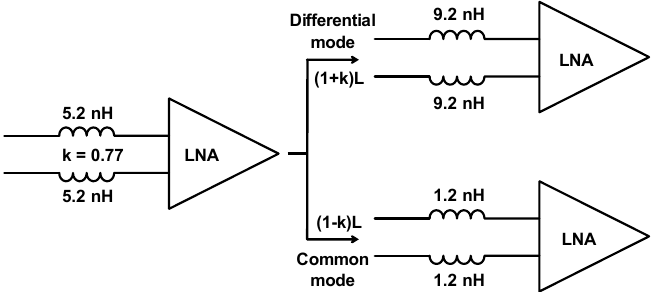
Figure 9. The behavior of a spiral transformer employed in a fully differential low noise amplifier (LNA) circuit will display a ( 1 + k ). L factor increase in inductance in differential-mode operation, and ( 1 − k ). L factor reduction in inductance in common-mode operation; where k stands for the coupling coefficient and L is the inductance [2].